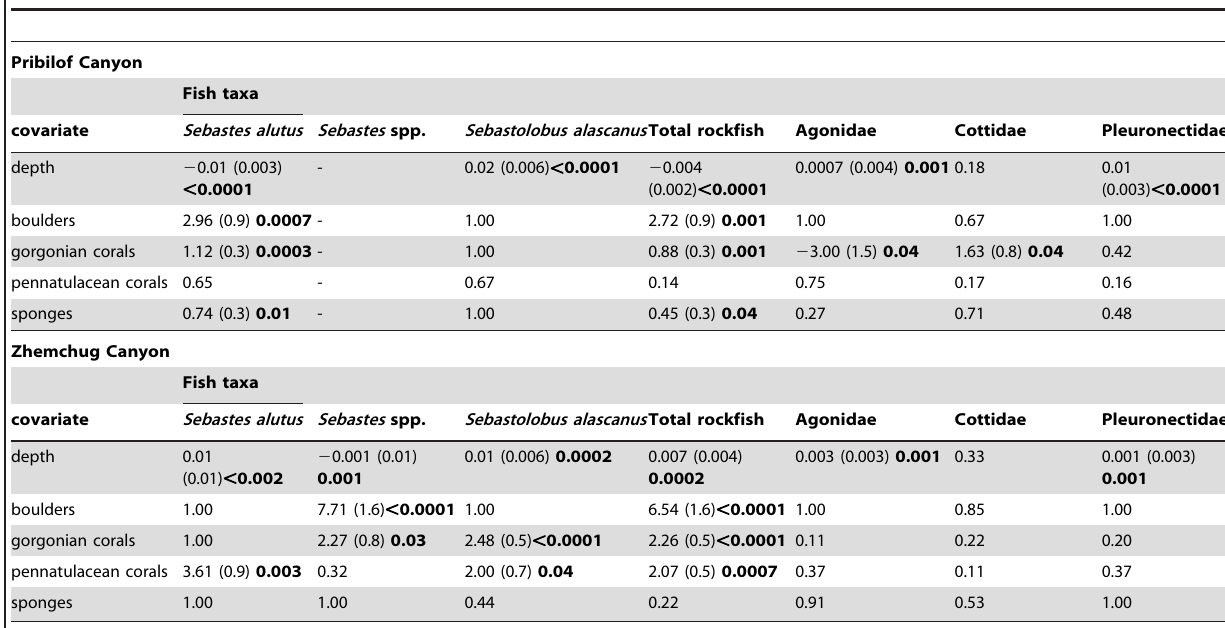
Table 3. Significance values ( p levels) for all GLM